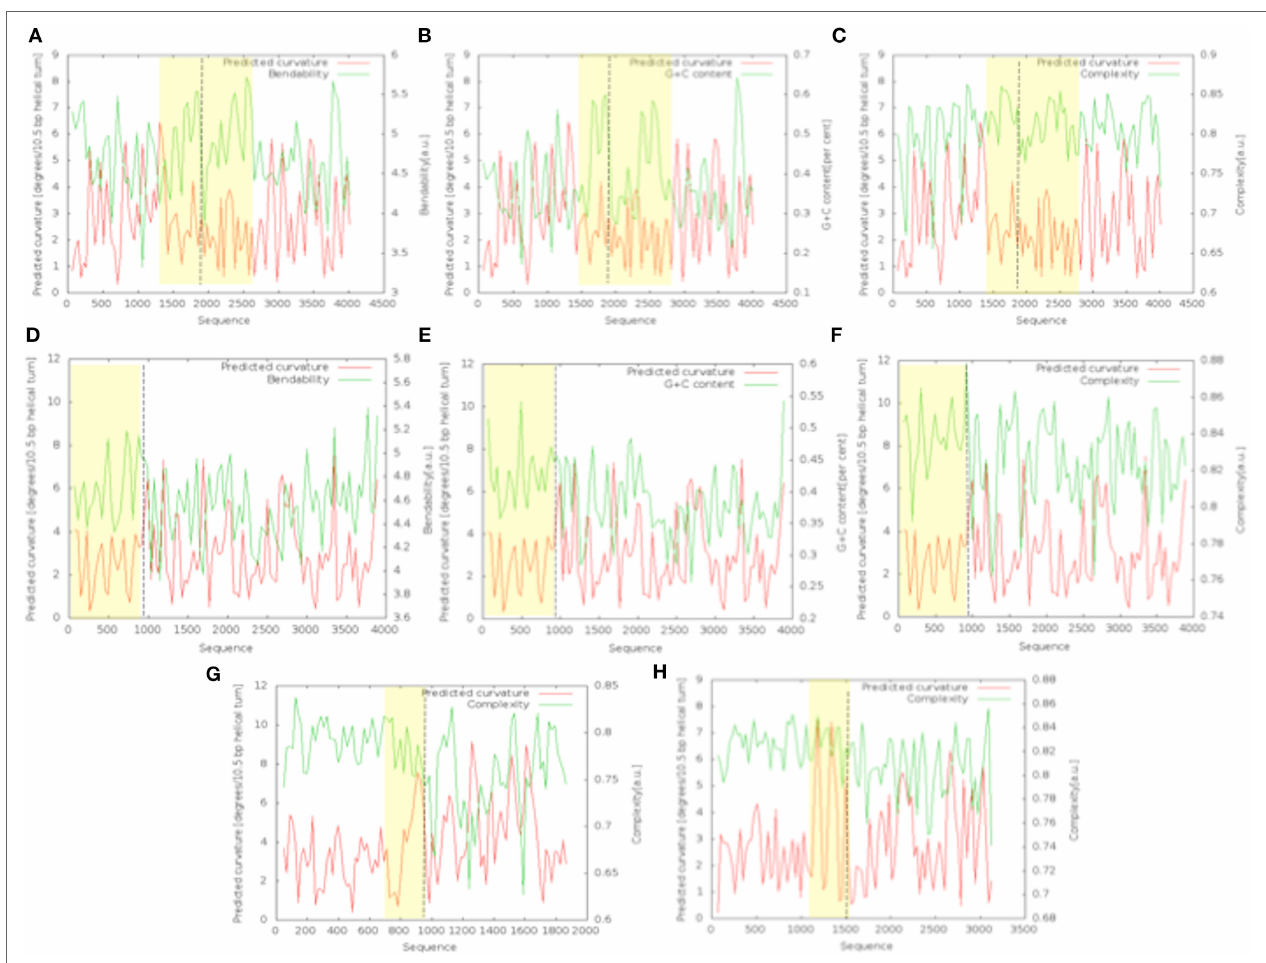
FigUre 5 | Bend.it analysis. The upper panel refers to the analysis of the genomic DNA around the breakpoint (in the figure at 1,982 bp) within NUP98 . The panel in the middle refers to the analysis of the breakpoint (in the figure at 982 bp) within NUP145 . (a–c) ( NUP98) and (D–F) ( NUP145) show the bendability, the GC content and the complexity of the genomic region against the curvature, respectively. The bottom panel refers to the comparison between the cDNA complexity of the junctions NUP145 - TOP2 (g) and NUP98 - TOP2B (h) . The breakpoints in the graphics are at 883 bp (g) and 1,666 bp (H). In all the panels, the Y -axis is reported as degrees/10.5 bp helical turn. Dashed lines indicate the breakpoints while the peculiar regions discussed in the text are outlined in